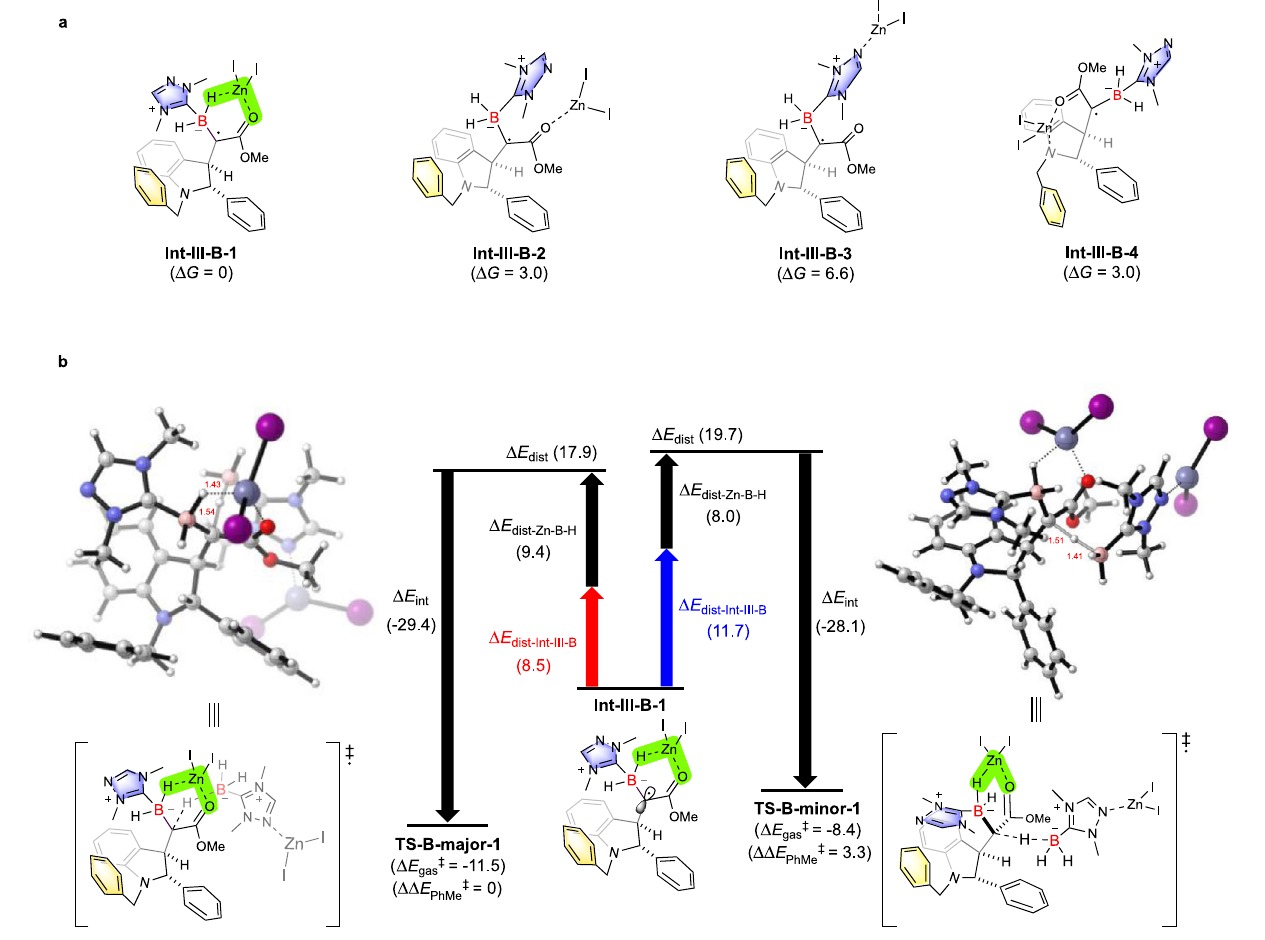
Fig. 7 Computational studies of ZnI 2 -mediated reactions. a Int-III-B with different chelation modes. b Analysis of the diastereoselectivity in the NHC- BH 3 /ZnI 2 -controlled HAT